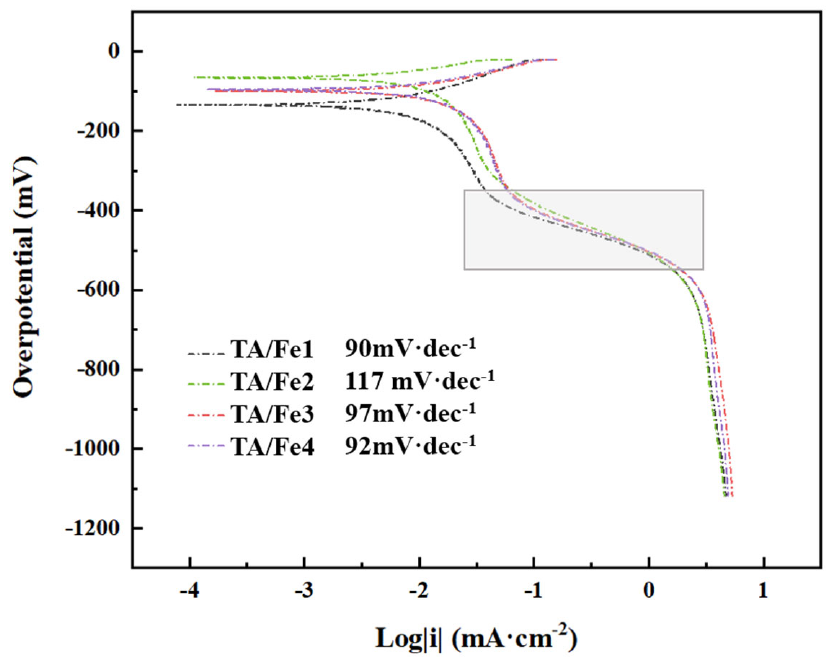
Figure 10. Tafel curves and stability of the titanium oxide ‐ based aerogel catalysts doped by different Fe sources. Fe sources.